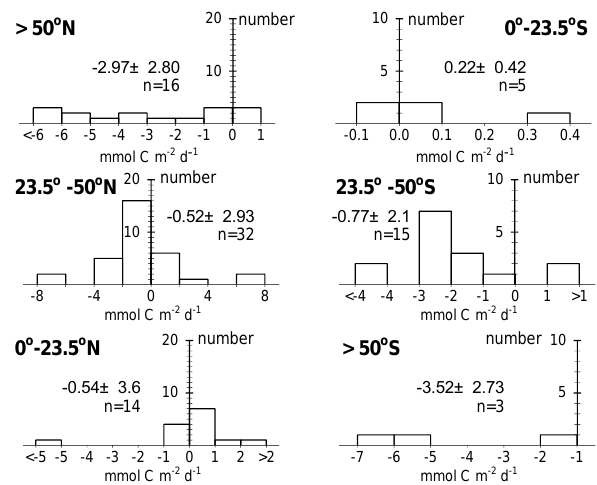
Fig. 10. Histogram of reported annual CO 2 fluxes of continental shelves in various latitude bands. 2 3